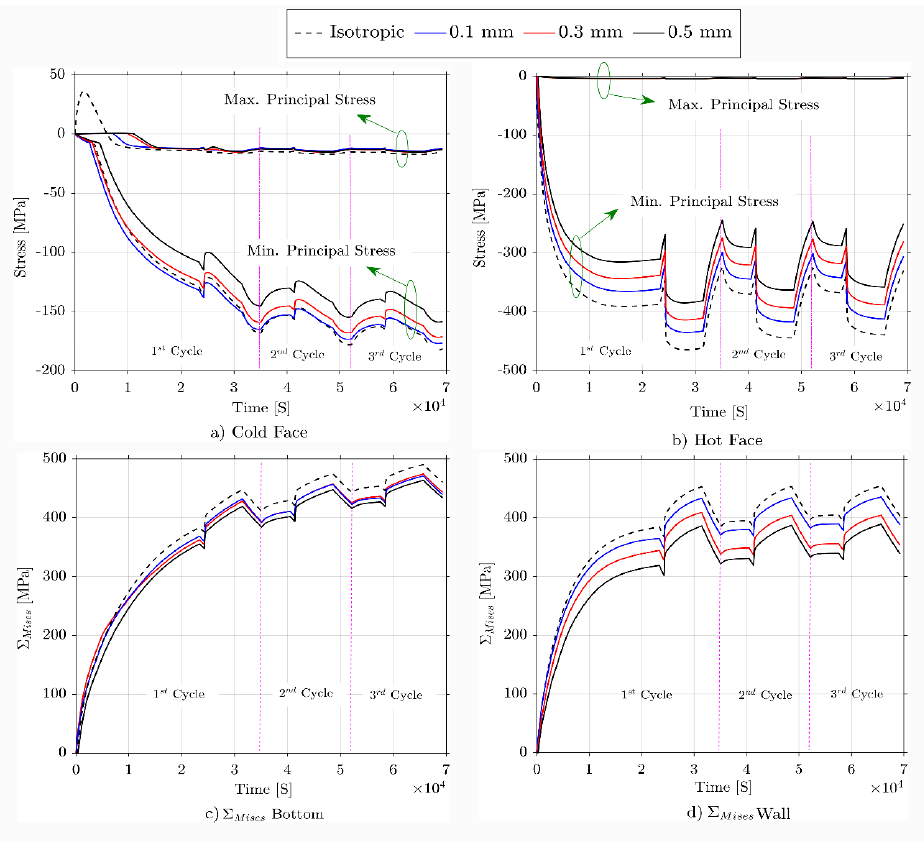
Figure 13. Time variations of maximum and minimum principal stresses in the ( a ) cold face and ( b ) hot face of the working lining, as well as Von Mises stresses in the steel shell ( c ) bottom and ( d ) wall.